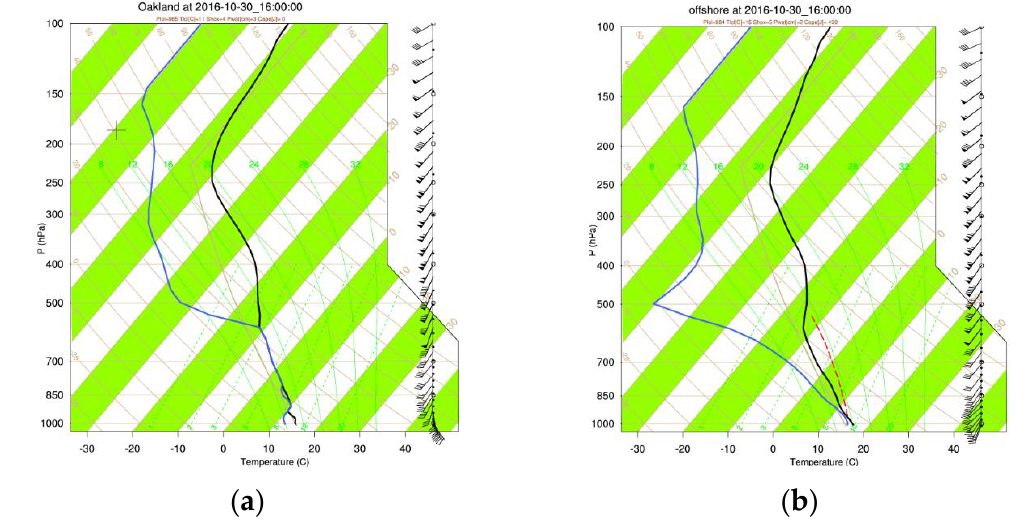
Figure 13. WRF-simulated soundings at grid point closest to OAK (left, a ) and to the southwest of Oakland over the ocean (right, b ). Both valid at 16 Z on 30 October 2016. Red dashed line in ( b ) indicates the presence of CAPE offshore at the time.